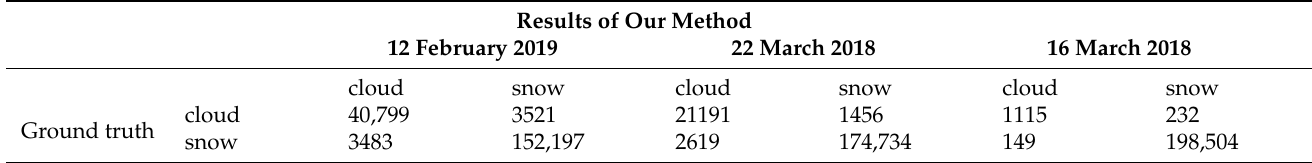
Table 4. Confusion matrix comparing ground truth and the results of our